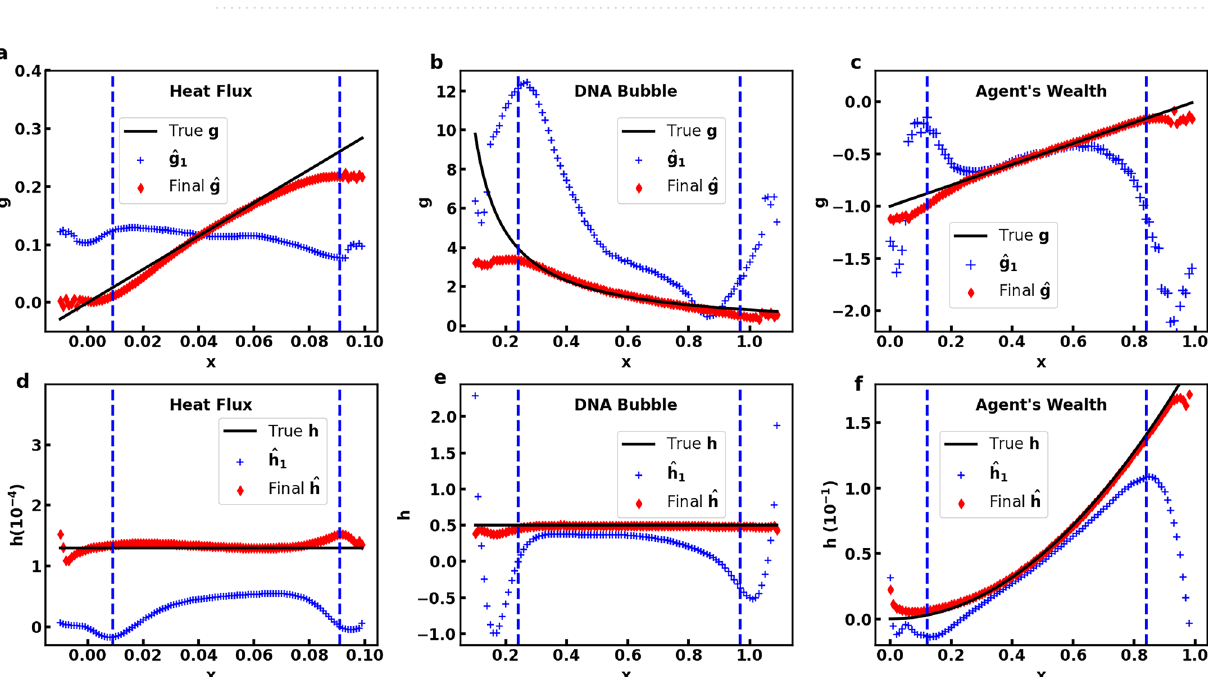
Figure 4. Comparison of the true g and h (black line) and the trained weights ˆ g and ˆ h from the first training iteration (blue cross) and the final iteration (red diamond) in heat flux ( a , d ), DNA bubble ( b , e ), and agent’s wealth ( c , f ) examples. The boundary area is indicated by the vertical blue dash line. ˆ g weights in the first iteration. They are the optimal FPE terms can be found based on the smoothed P noisy ( t ) , ˆ P 0 ( t ) . The figure shows that ˆ g 1 and ˆ h 1 are significantly different from their true values, suggesting that merely smoothing P noisy ( t ) is insufficient. To further reduce the noise by training ˆ P ( t ) with FPE-NN is essential for the ˆ g and ˆ h